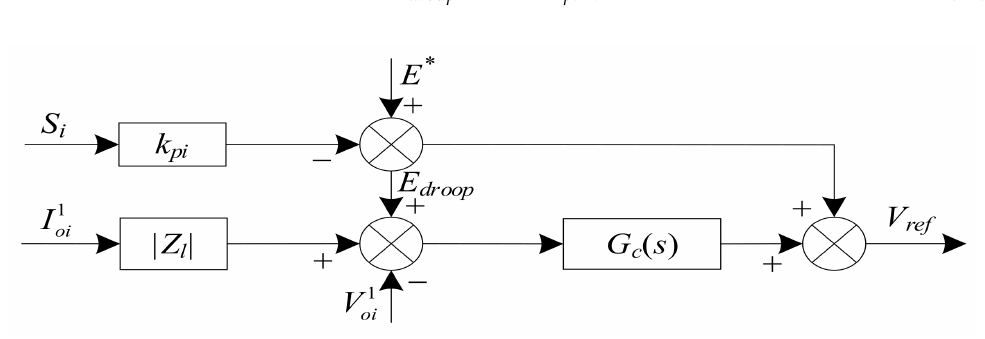
Figure 7. Improved active droop control block